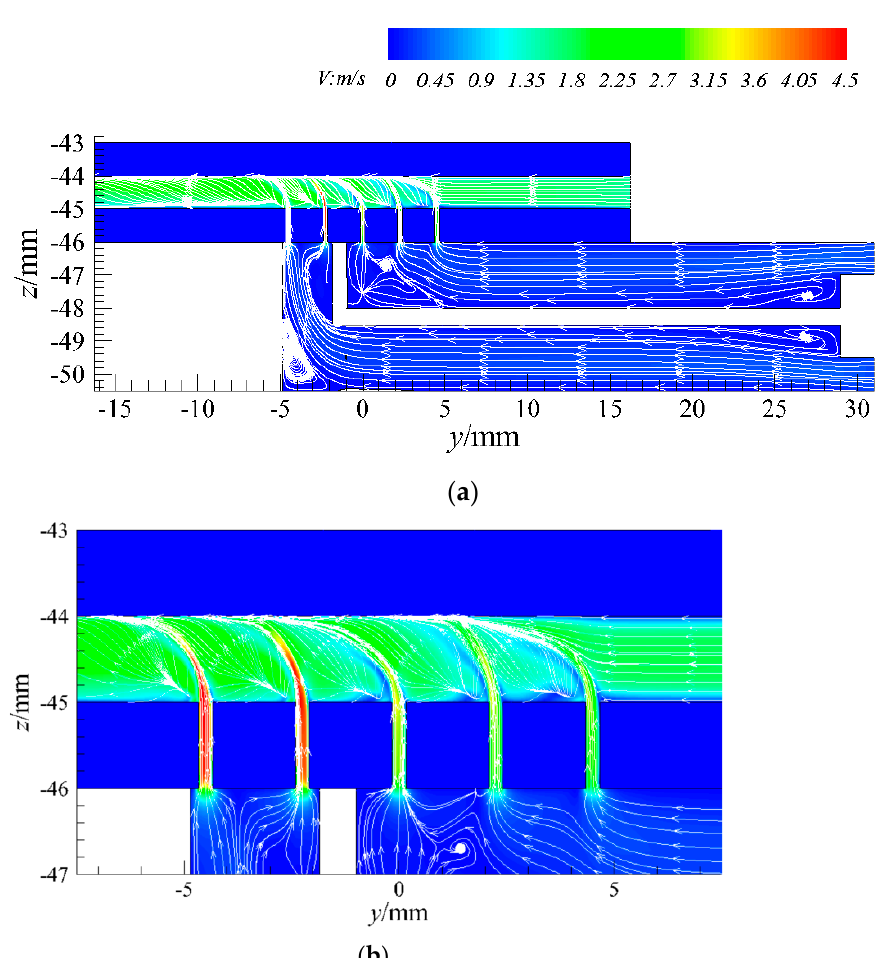
Figure 11. Velocity distribution (DSJ off) of channel’s center section ( x = 28.5 mm): ( a ) overall view; ( b ) partial enlarged view of jet orifice area.